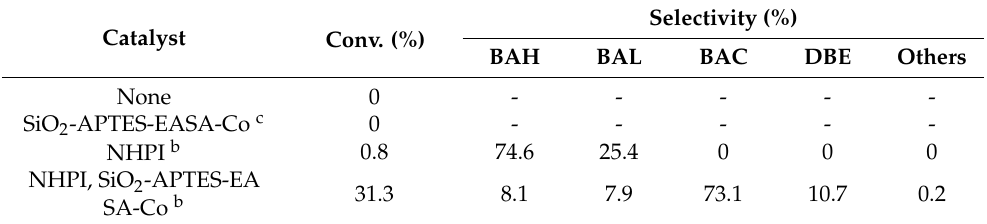
Table 5. Performance of the catalysts for solvent-free oxidation of toluene via molecular oxygen a . Catalyst